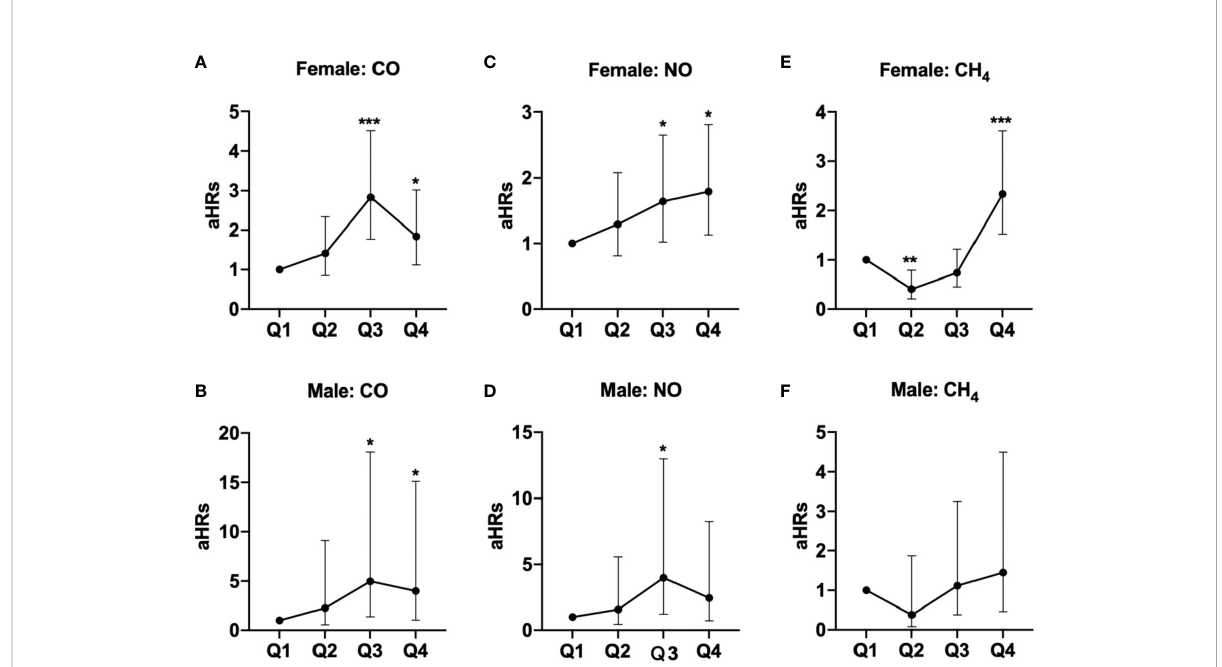
FIGURE 2 Illustrated hazard ratios (HRs) of pSS in females and males exposed to ( A , female; B , male) CO, ( C , female; D , male) NO, and ( E , female; F , male) CH 4 . *p<0.05; ***p<0.001.